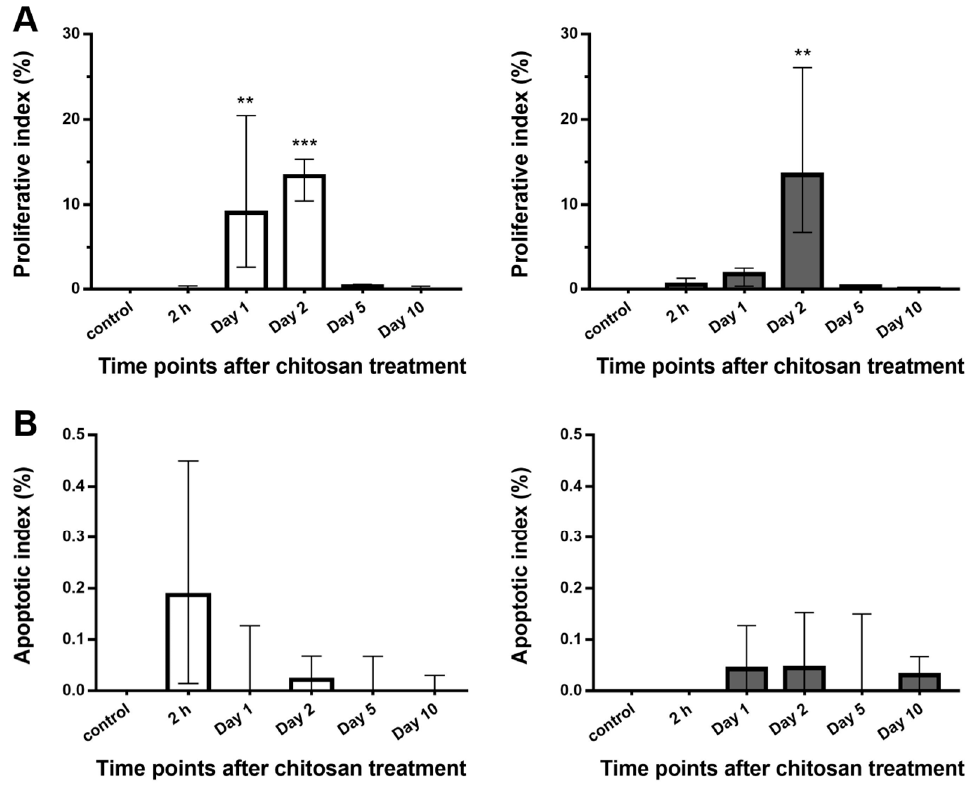
Figure 5. ( A ) Proliferative activity of the urothelium in young mice (white columns) is significantly increased on day 1 and 2 after chitosan treatment and in old mice (grey columns) on day 2 after chitosan treatment. Two tissue sections from each of 3 animals per time point. ( B ) Apoptotic activity of the urothelium is increased only 2 h after chitosan treatment in young mice (white columns) while in the urothelium of old mice (grey columns), apoptotic activity is low at all selected time-points. Two tissue sections from each of 2 animals per time point. Median ± interquartile range (IQR). ** p < 0.01, *** p < 0.001.